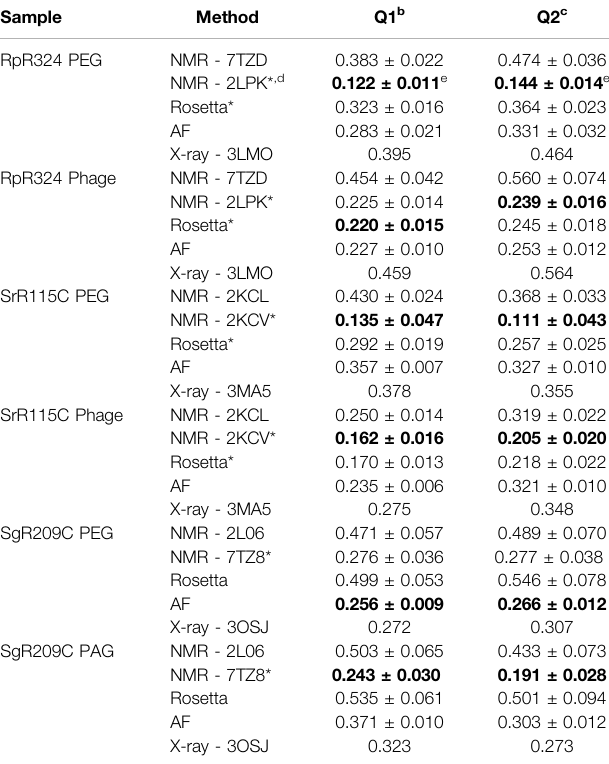
TABLE 3 | 15 N- 1 H RDC Q Factors for experimental and AF models a .